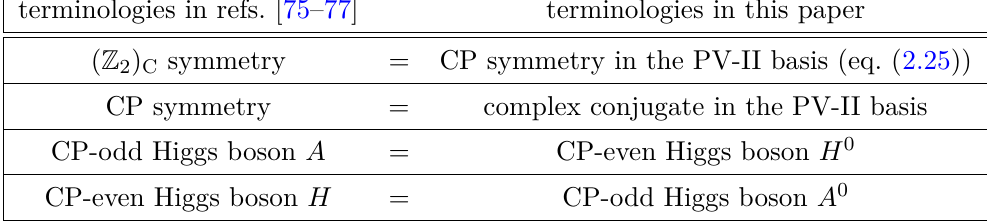
Table 1 . Summary table of difference of conventions from previous